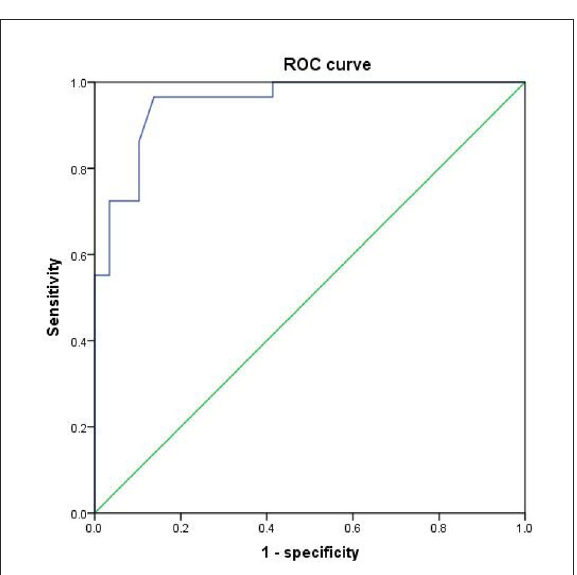
FIGURE4 ROC curve of PerAF differences in brain areas. ROC, receiver operating characteristic; PerAF, percent amplitude of fluctuation.